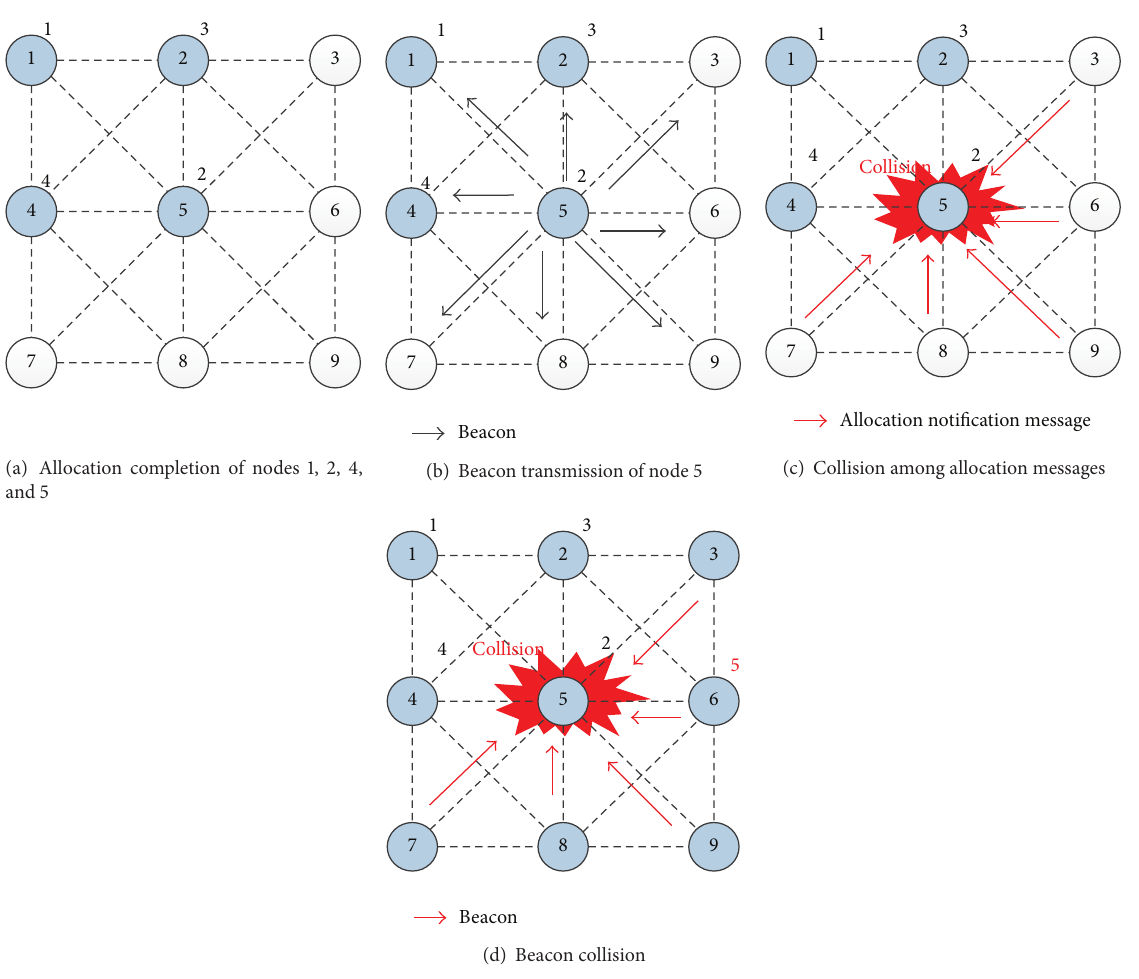
Figure 5: An example of collision among allocation notification messages.